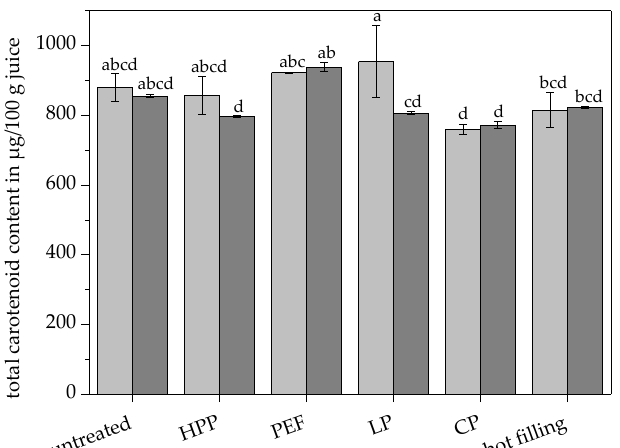
Figure 1. Total carotenoid contents in the untreated and pasteurized juices without ( (cid:4) ) and with ( (cid:4) ) ultrasonication. Different letters indicate significant differences ( p ≤ 0.05). Values are means ± standard deviation (n = 3).